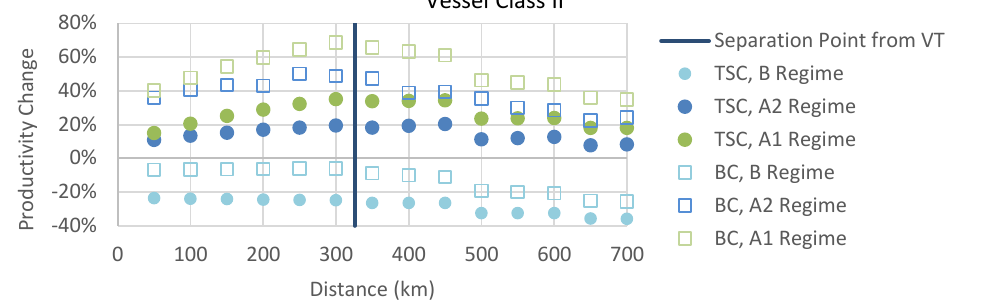
Figure 10: Productivity Change For Vessel Class